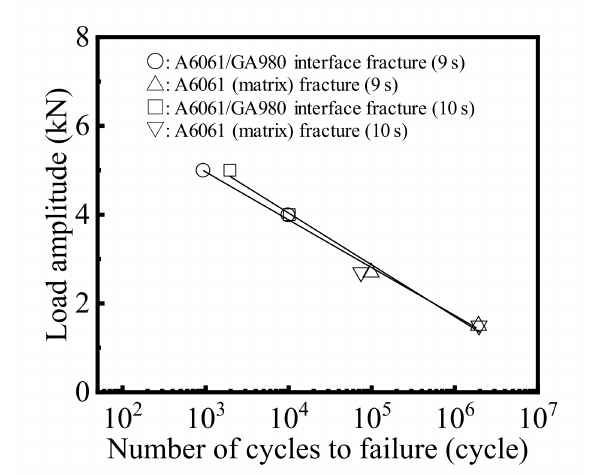
Figure 12. Results of the tensile shear fatigue test.